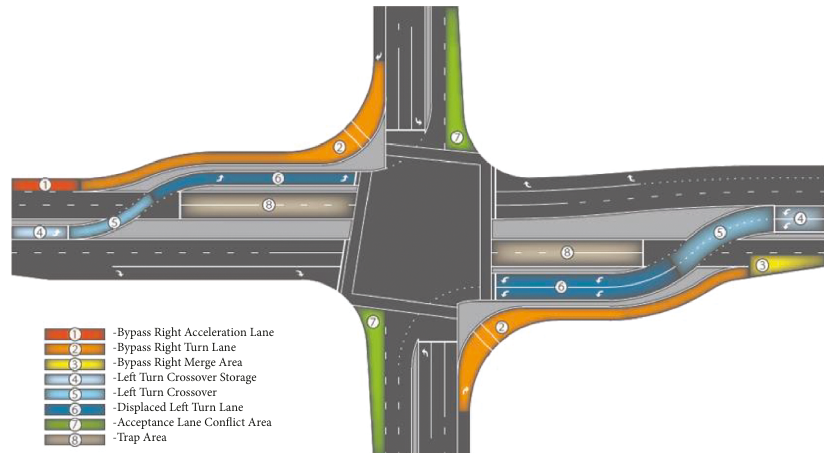
Figure 1: Layout of a two-leg continuous flow intersection [12].